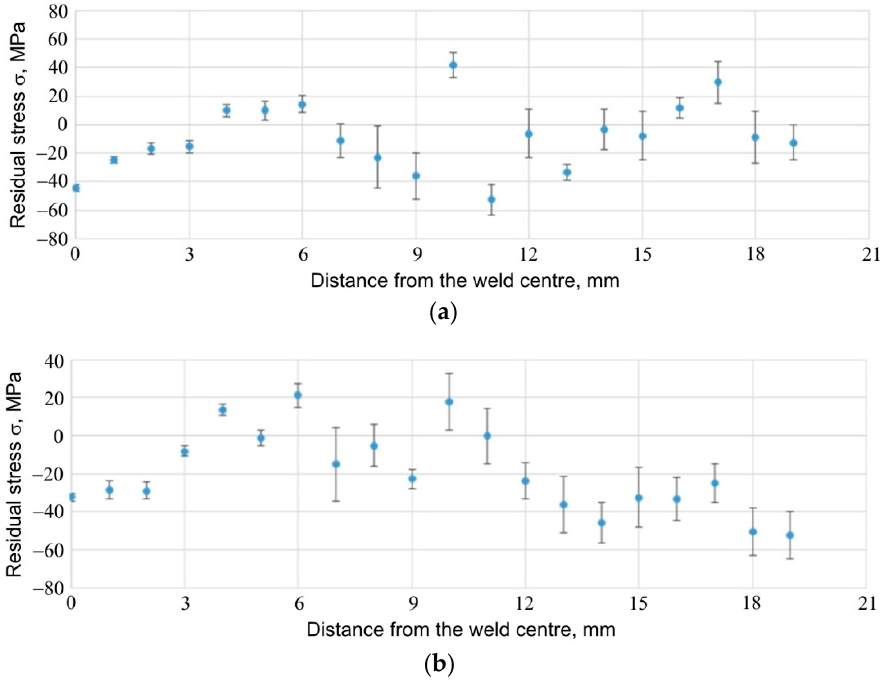
Figure 27. Stresses present in and around the RFSSW joint for specimen E5, for 0.8 mm thick sheet; ( a ) tangential and ( b ) radial component of stresses.